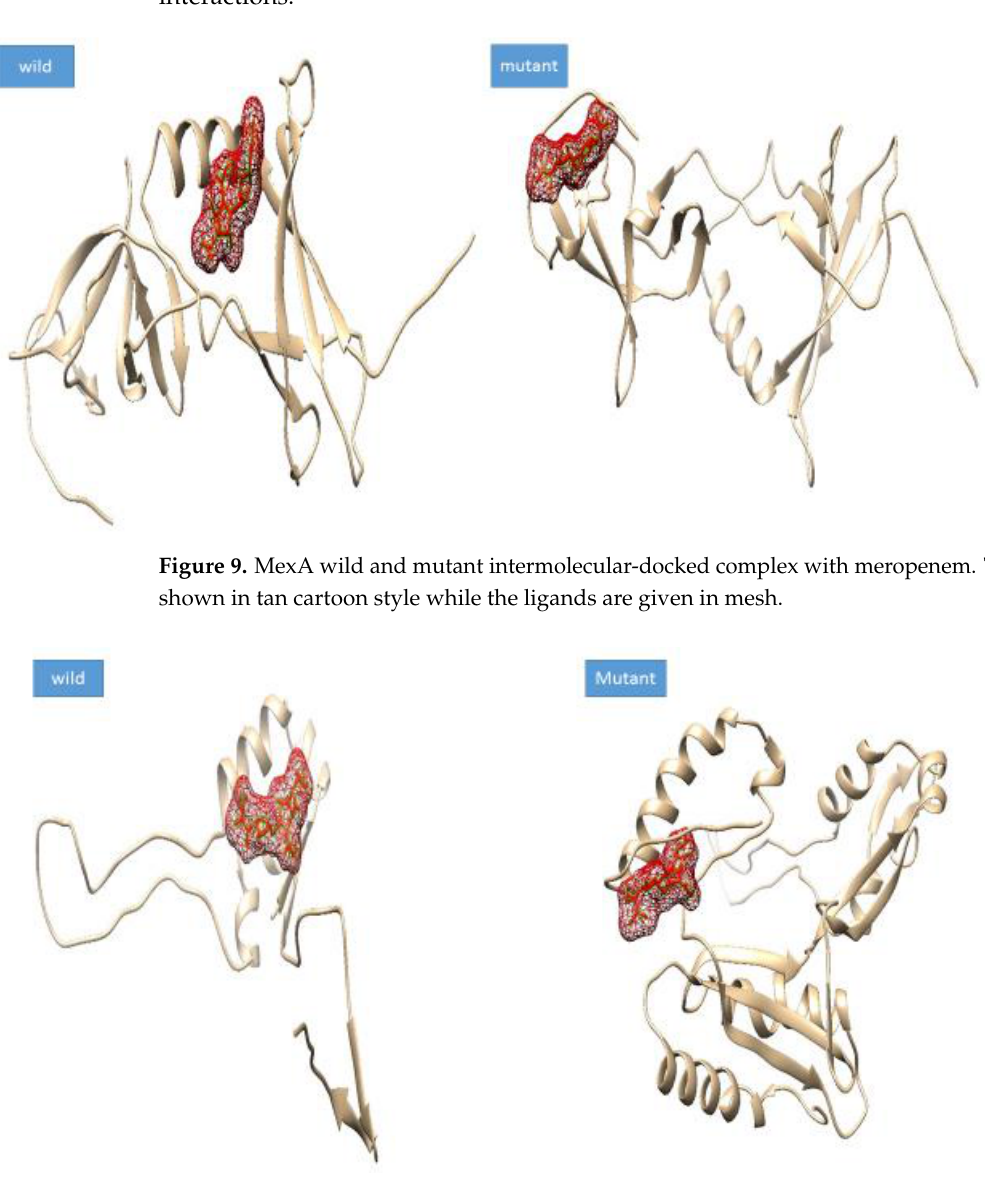
Figure 10. Binding conformation of meropenem with the mexB wild and mutant proteins. The proteins are shown in tan cartoon style while the ligands are given in mesh.